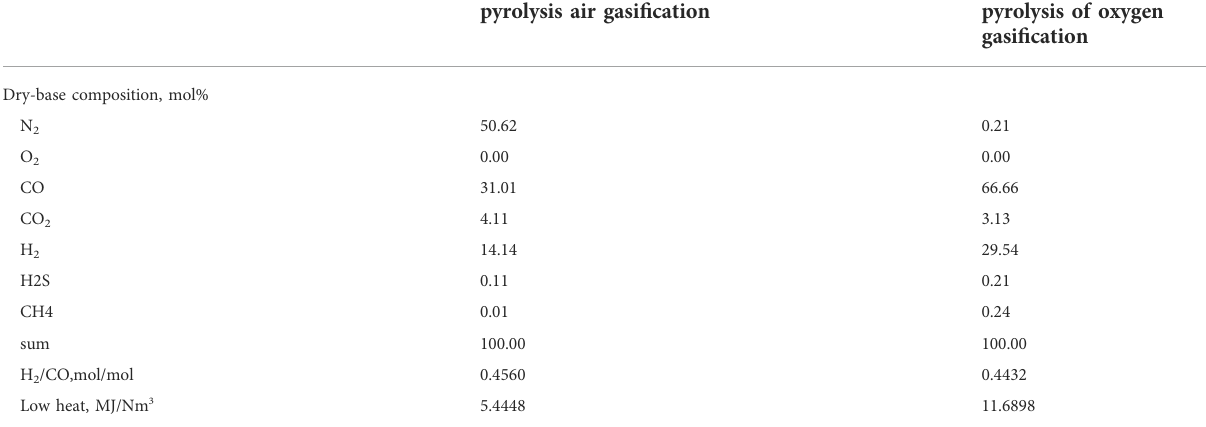
TABLE 7 Composition of fuel gas and syngas in the fl exible fl uidized pyrolysis process. Process